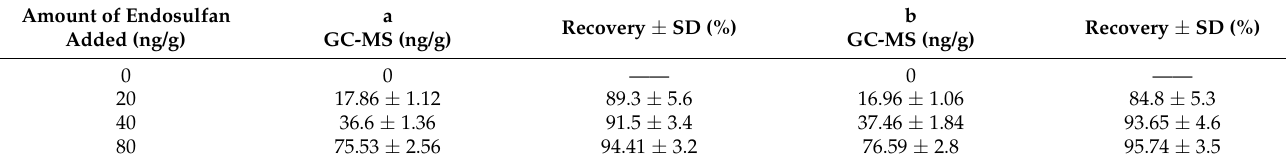
Table 5. GC-MS analysis of the spiked samples (a: pear; b: apple).